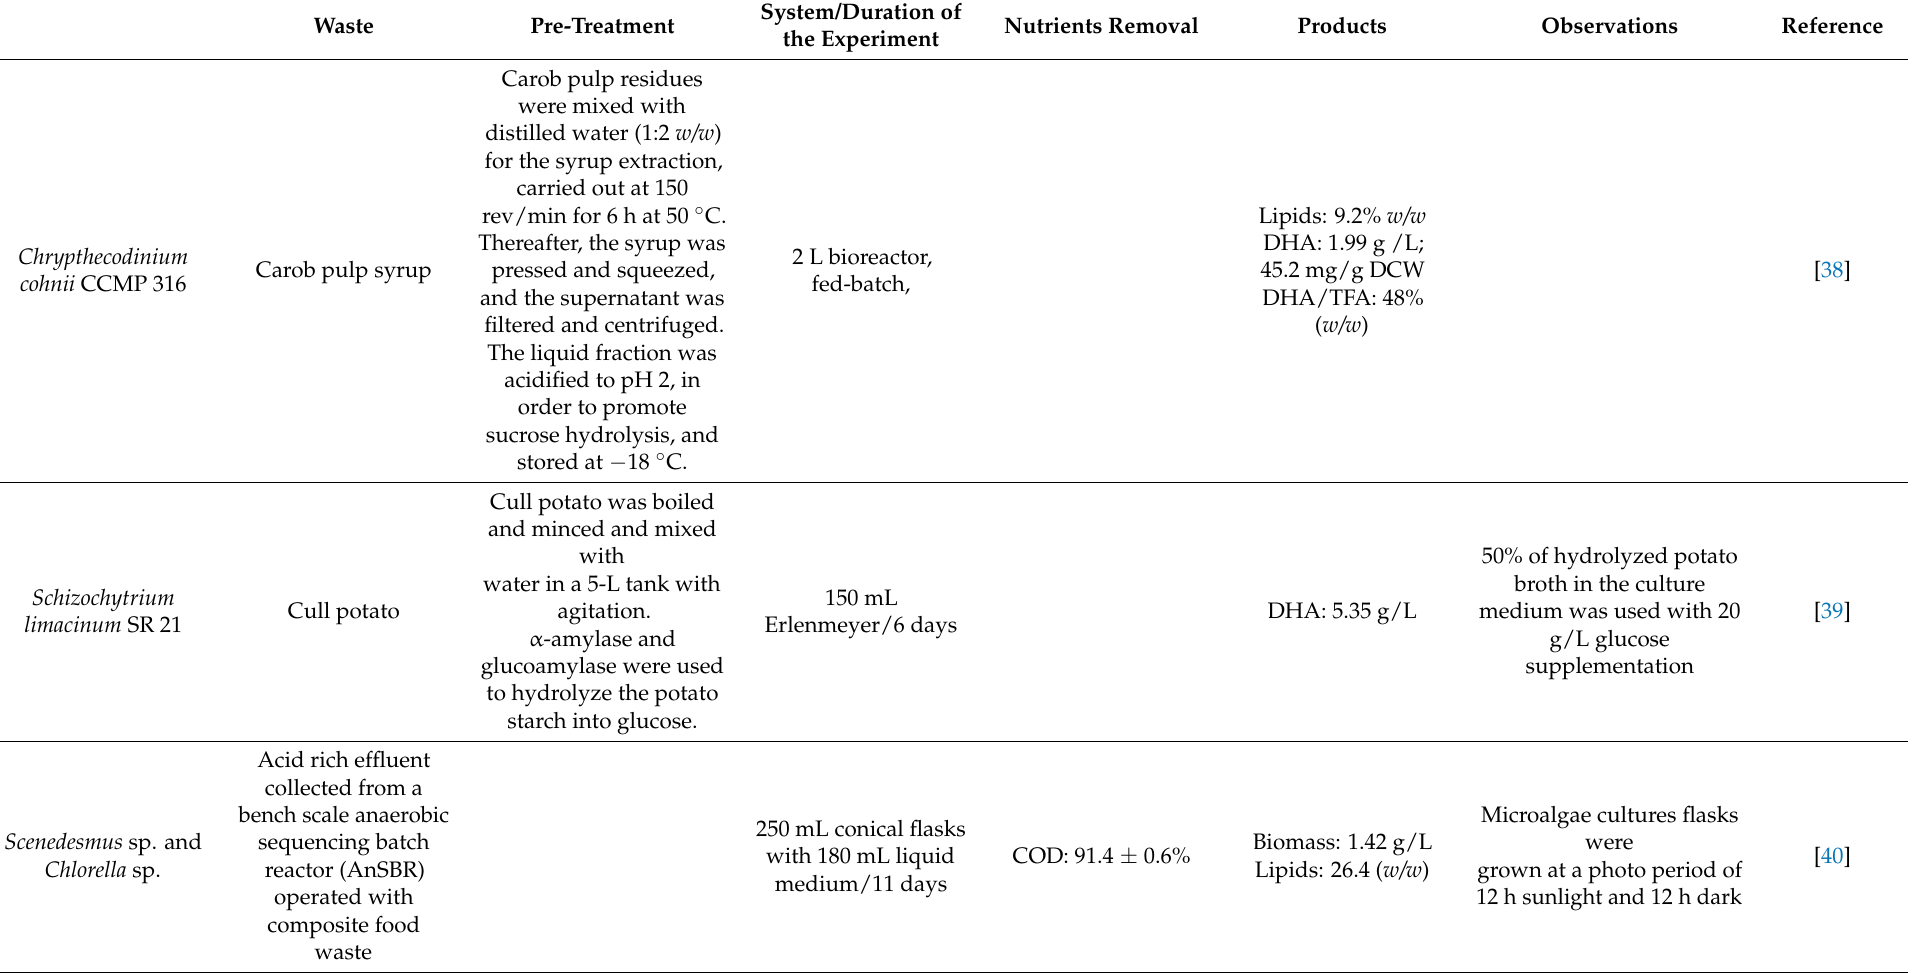
Table 2. Heterotrophic microalgae that have been reported to treat